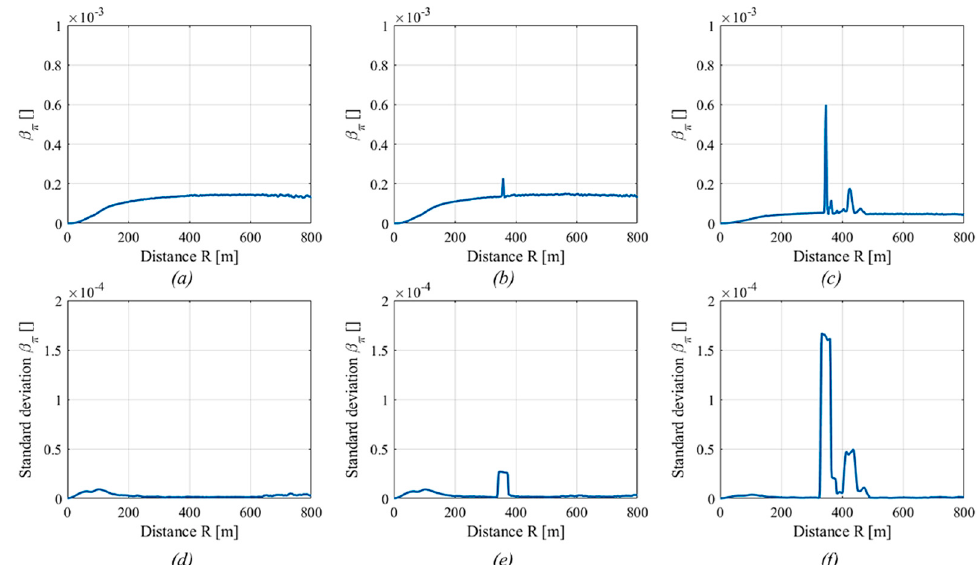
Figure 3. Backscattering coefficient amplitude ( a–c ) and standard deviation ( d–f ) as a function of the distance in the case of no smoke (pulse 10, a and d ), small smoke plume (pulse 15, b and e ), and large smoke plume (pulse 21, c and f ).